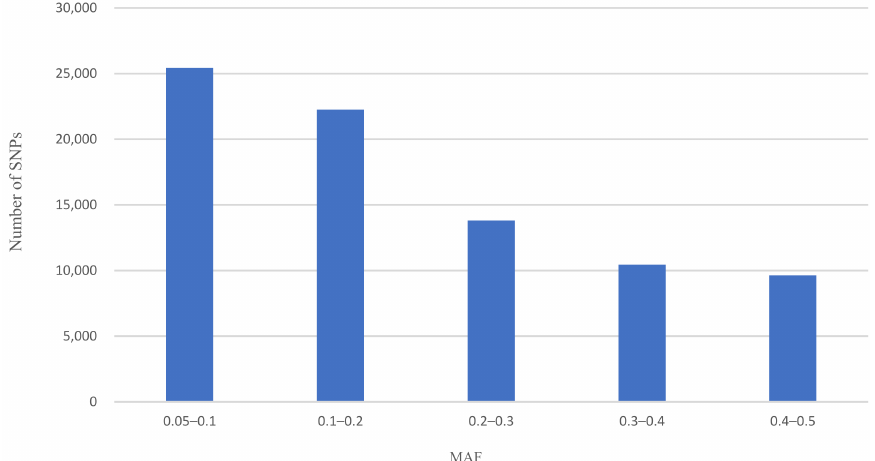
Figure 1. Distribution of minor allele frequency (MAF) for SNP after